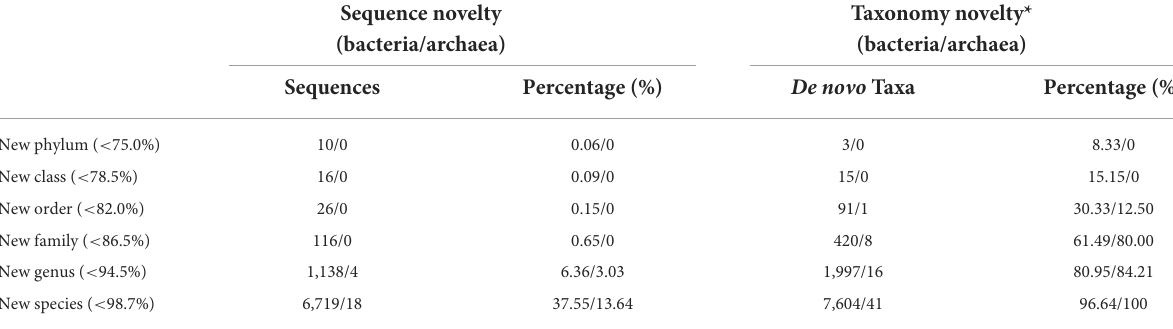
TABLE 1 Novel sequences and de novo taxa observed in the AsCoM reference database.